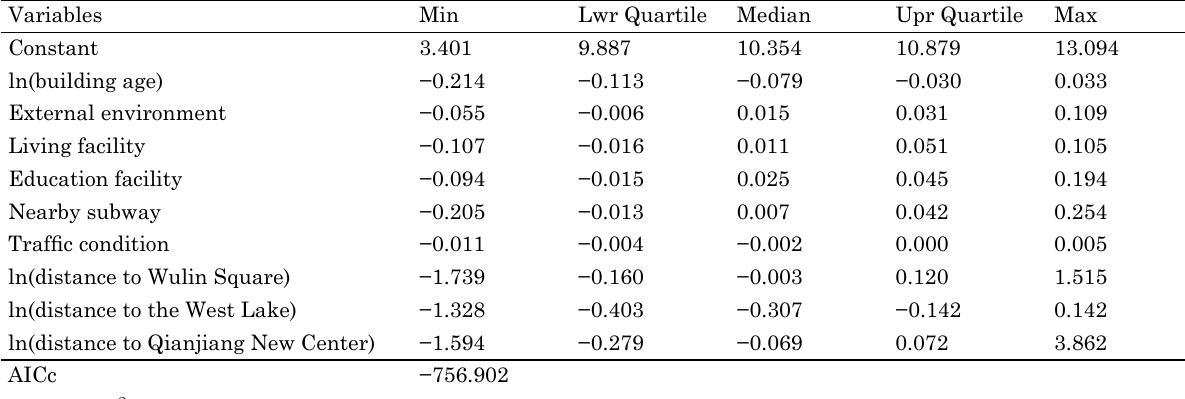
Table 6. Regression results for local